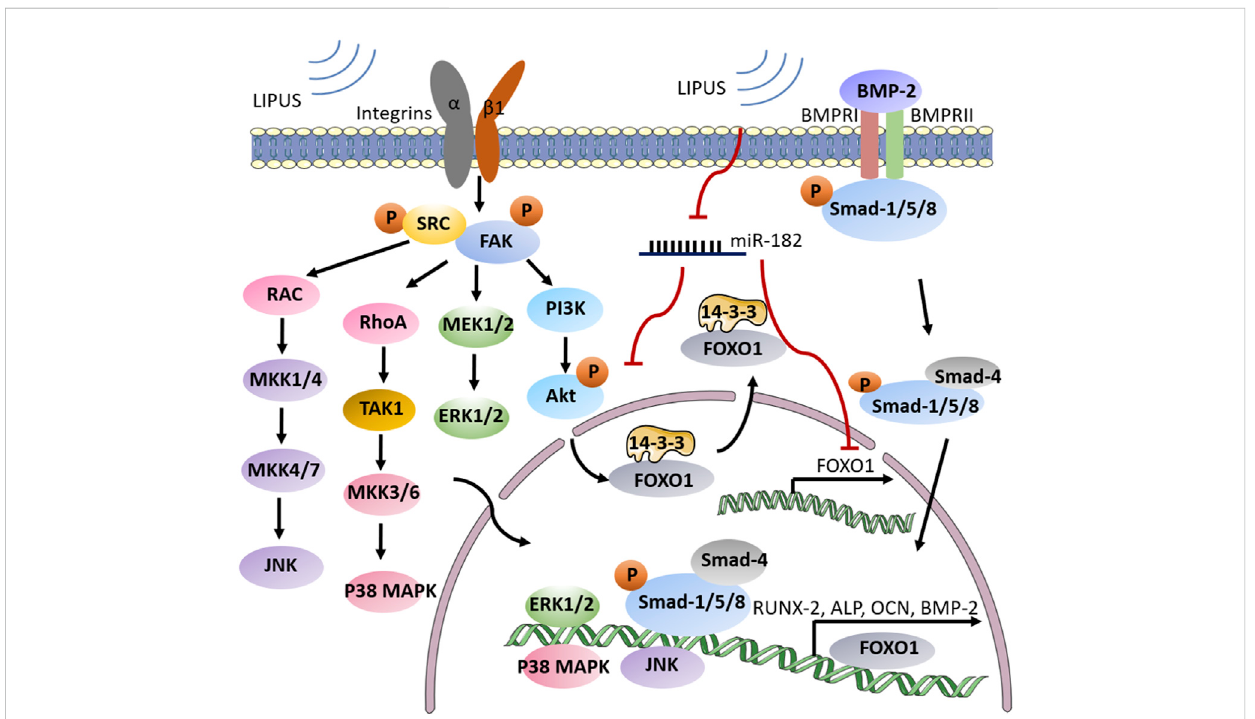
FIGURE 3 Schematic illustration of LIPUS enhancing osteogenic differentiation in periodontal tissue. LIPUS promotes FAK phosphorylation through integrin β 1 and subsequently activates MAPK signaling, enabling the transcription of osteogenic-related signaling factors. Meanwhile, LIPUS can reverse